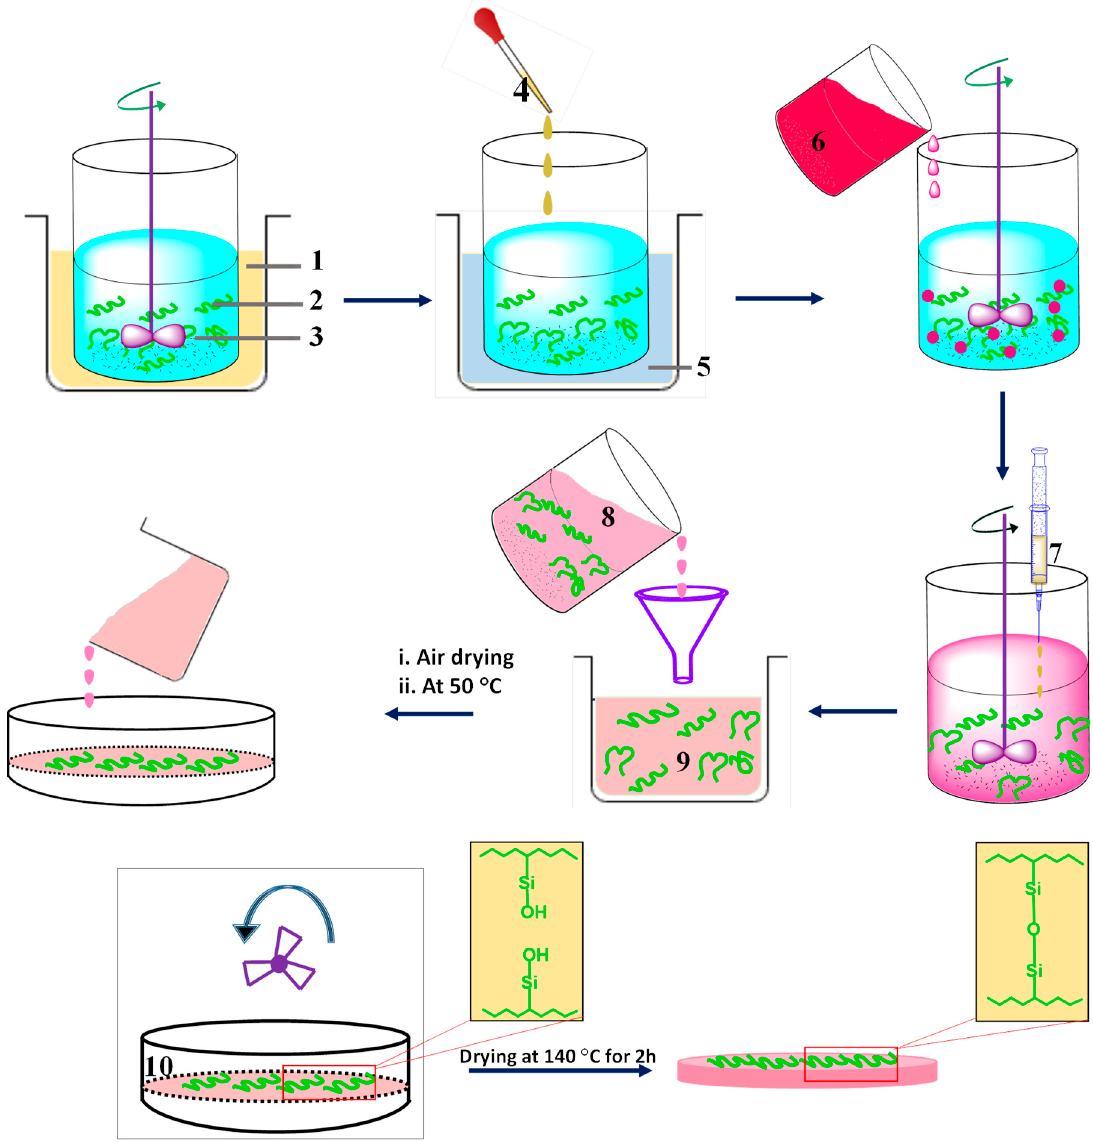
Figure 7. Sol-gel method for preparing PV-membrane: 1. PVA Chains, 2. Silicone oil bath at 90 C, 3. Water, 4. Cold water, 5. Concentrated HCl, 6. MA, 7. TEOS-ethanol mixture, 8. Reaction mixture, 9. Filtrate, 10. Membrane film.